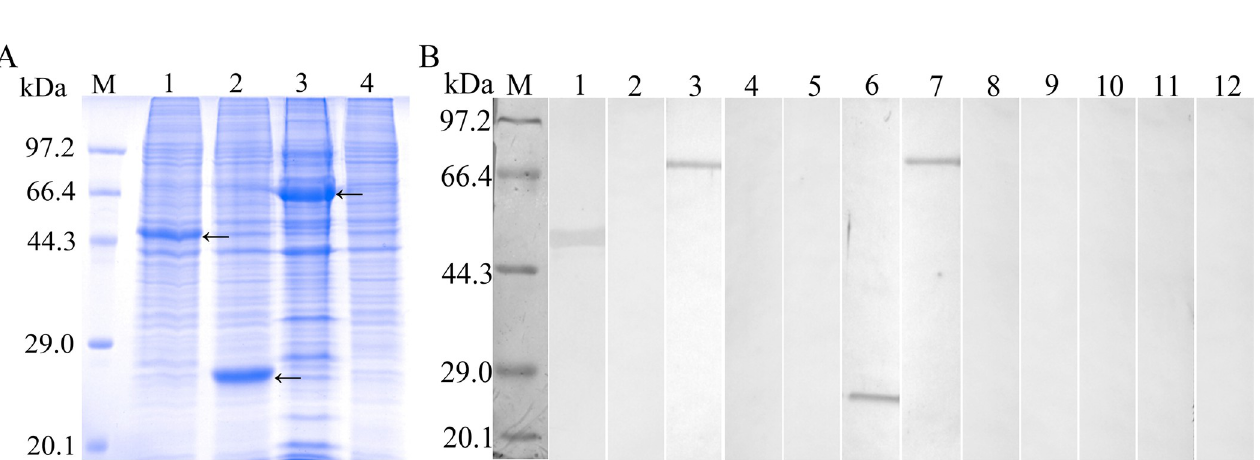
Fig 4. Western blotting of the in vitro expression of TsCRT+TsSP1.1, TsCRT and TsSP1.1. A: SDS-PAGE analysis of soluble proteins of transfected 293T cells. Lane M: protein marker. Lane 1: pcDNA3.1-TsCRT transfected cells. Lane 2: pcDNA3.1-TsSP1.1 transfected cells. Lane 3: pcDNA3.1-TsCRT+TsSP1.1 transfected cells. Lane 4: empty pcDNA3.1 transfected cells. B : Western blot analysis of protein expression of TsCRT (lane 1, 5, 9), TsSP1.1 (lane 2, 6, 10) and TsCRT+TsSP1.1 (lane 3, 7, 11) in transfected cells by anti-rTsCRT serum (Lane 1–4), anti-rTsSP1.1 serum (Lane 5–8) and normal serum (Lane 9–12). No protein bands of pcDNA3.1 transfected cells (lane 4, 8, and 12) were identified by anti-rTsCRT serum (Lane 4), anti-rTsSP1.1 serum (Lane 8) and normal serum (Lane 12). Three expressed protein bands of TsCRT, TsSP1.1 and TsCRT+TsSP1.1 with about 47, 26.07 and 71.53 kDa were indicated by arrows.